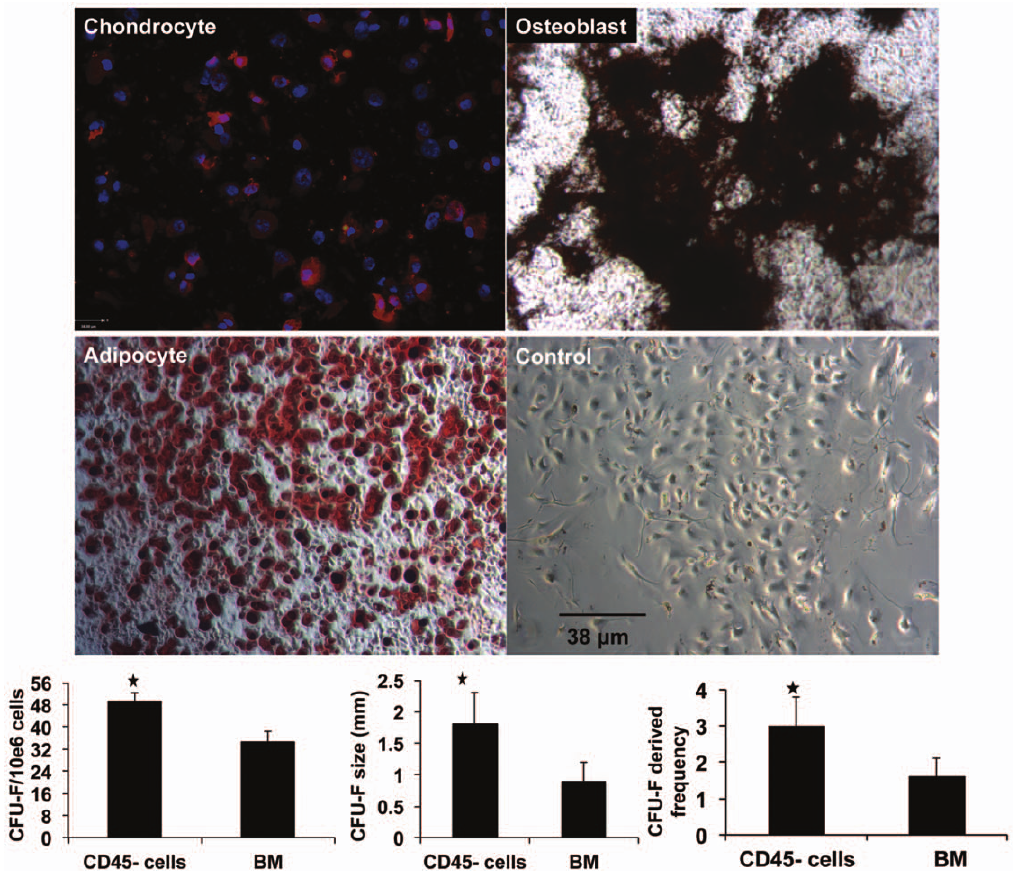
Figure 7. Functional assays for multipotent mesenchymal stromal cell (MSCs). Photomicrographs of CD45 2 /TER119 2 cells that undergone chondrocytic, osteogenic and adipocytic differentiation when cultured in differentiation media. Lower right photomicrograph represents CD45 2 / TER119 2 cells cultured in non-differentiating media (negative control). Collagen II (red) and DAPI (blue nuclei) are used to identify chondrocytes. Von kossa (black) and oil red stainings were used to identify osteoblasts and adipocytes, respectively. Graphs represent the number, size, and frequency of colony-forming unit fibroblasts (CFU-F) of CD45 2 /TER119 2 cells versus whole bone marrow cells. All three graphs show that CD45 2 /TER119 2 cells had higher CFU-F than whole bone marrow cells (* P , 0.05).